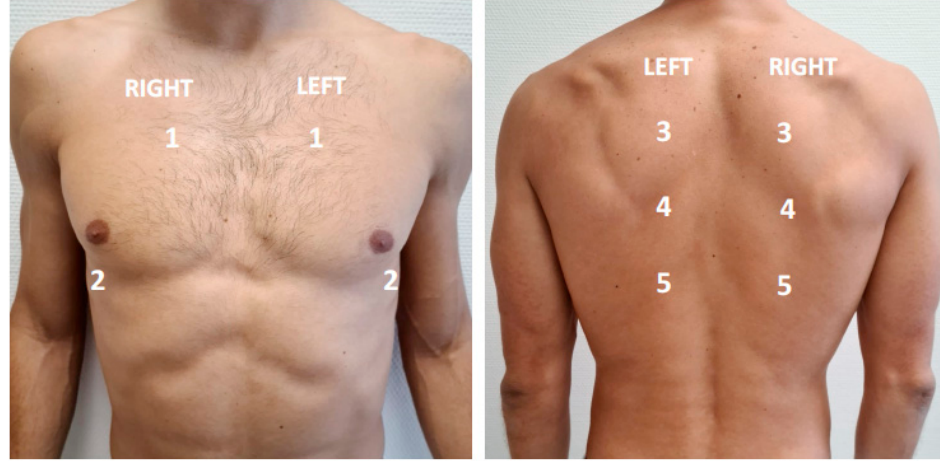
Figure 1. Lung ultrasound examination protocol using 10 zones.